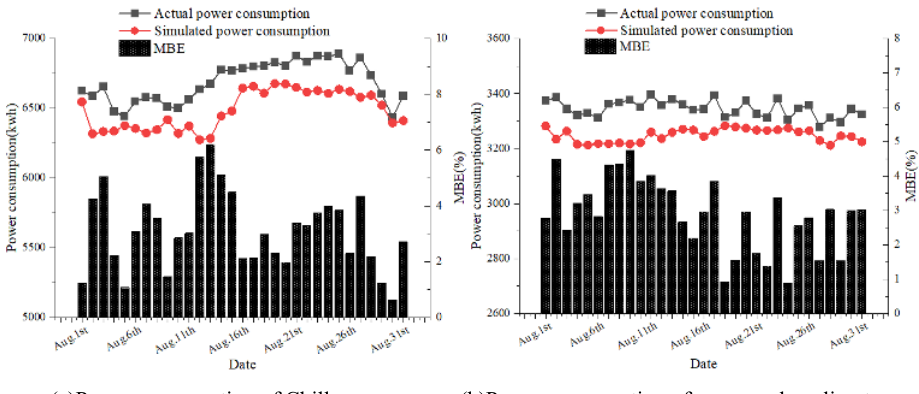
Fig. 4 . Comparison of power consumption between simulation and reality.